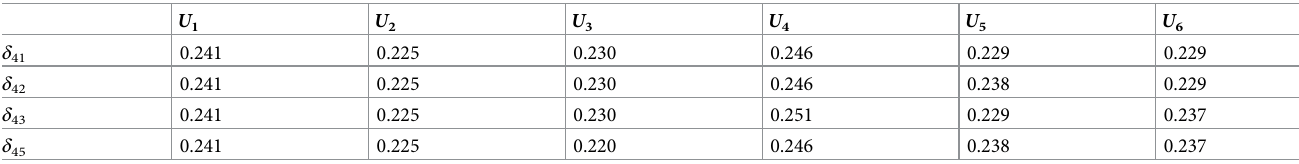
Table 12. The transformed probability of alternative O 4 to others.